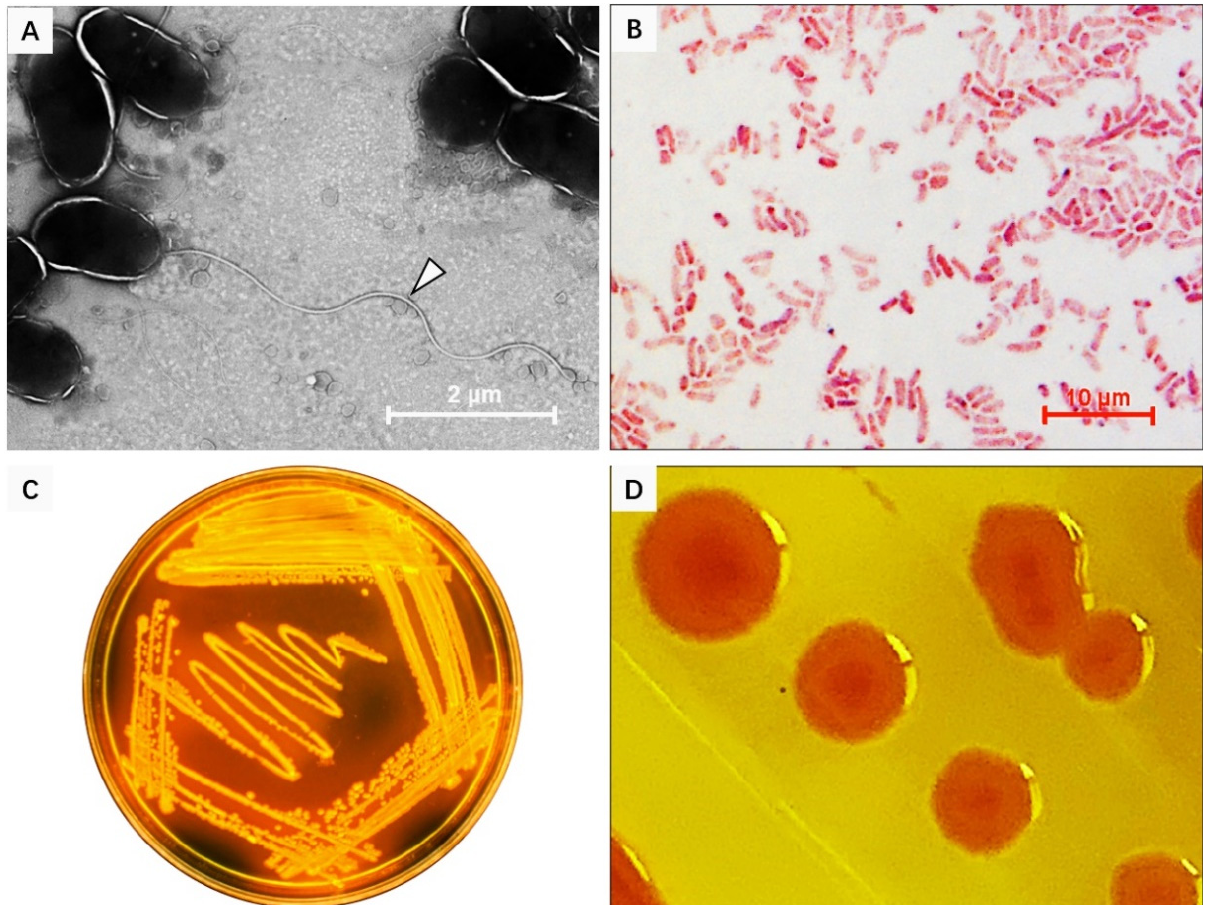
Figure 3. Morphological characteristics of V. kanaloae strain SbA1-1. ( A ) The morphological structure of SbA1-1, white arrow indicates the flagellum. SbA1-1 grew in liquid, was negatively stained with 2% phosphotungstic acid, and examined under TEM. Magnification, ×5000. ( B ) The characteristics of SbA1-1 after Gram staining. SbA1-1 shows red staining with a curved rod shape. ( C , D ) Colonial morphology and color of SbA1-1 on Thiosulfate Citrate bile salts sucrose (TCBS) agar.